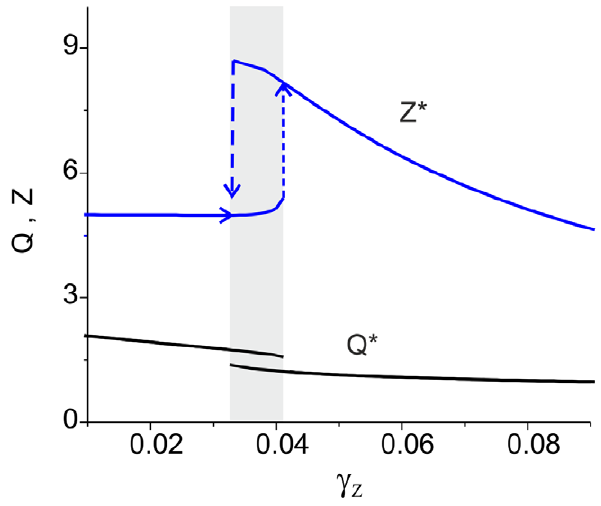
Figure 7. Dynamics of the ECM-protease regulation cascade depending on the feedback gain obtained in the simulation of Eqs. (9) and (14) for different initial conditions. The gray area illustrates bistability. Parameter values: z 0 = p 0 = 0, z 1 = p 1 = 1, h z =1,k z =0.15, h p =1.5,k p =0.05, a z =0.001 msec 2 1 , b z =0.01 msec 2 1 , a p = 0.001 msec 2 1 , b p = 0.01 msec 2 1 , c P = 0.1, a 1 = 0.0001 msec 2 1 , a 2 =0.001 msec 2 1 , I 0 =4.5, b 0 =6, Q 0 =2.23, and k I =0.6625 .